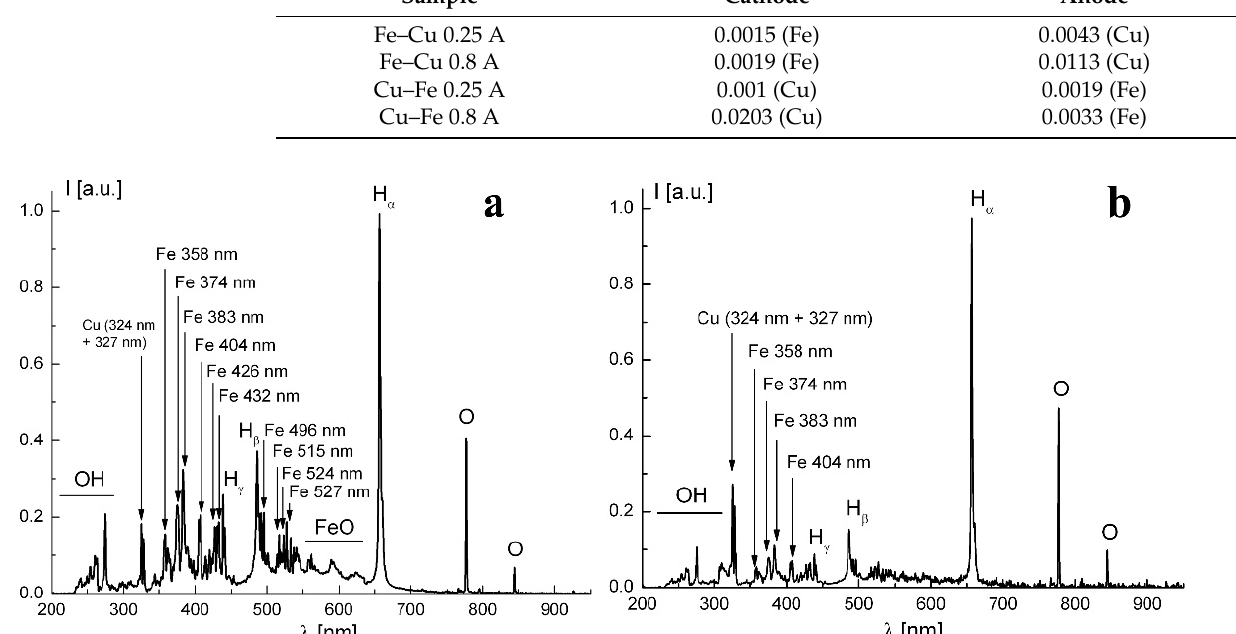
Figure 2. Emission spectra of the underwater plasma with Fe anode and Cu cathode ( a ) and Cu anode and Fe cathode ( b ). anode and Fe cathode ( b